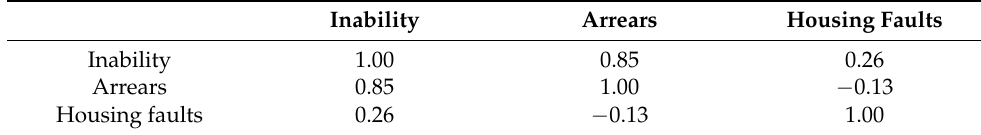
Table 3. Correlation matrix between input indicators of energy poverty.